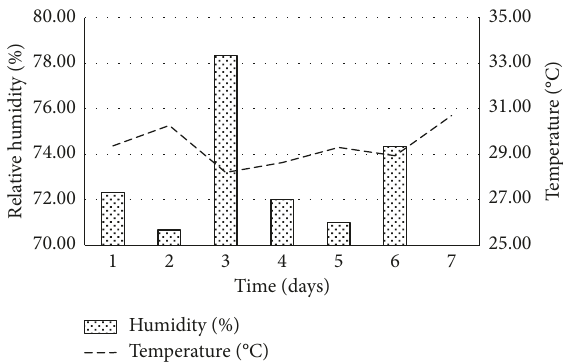
Figure 3: Evolution of temperature and relative humidity of the laboratory during the experiment.